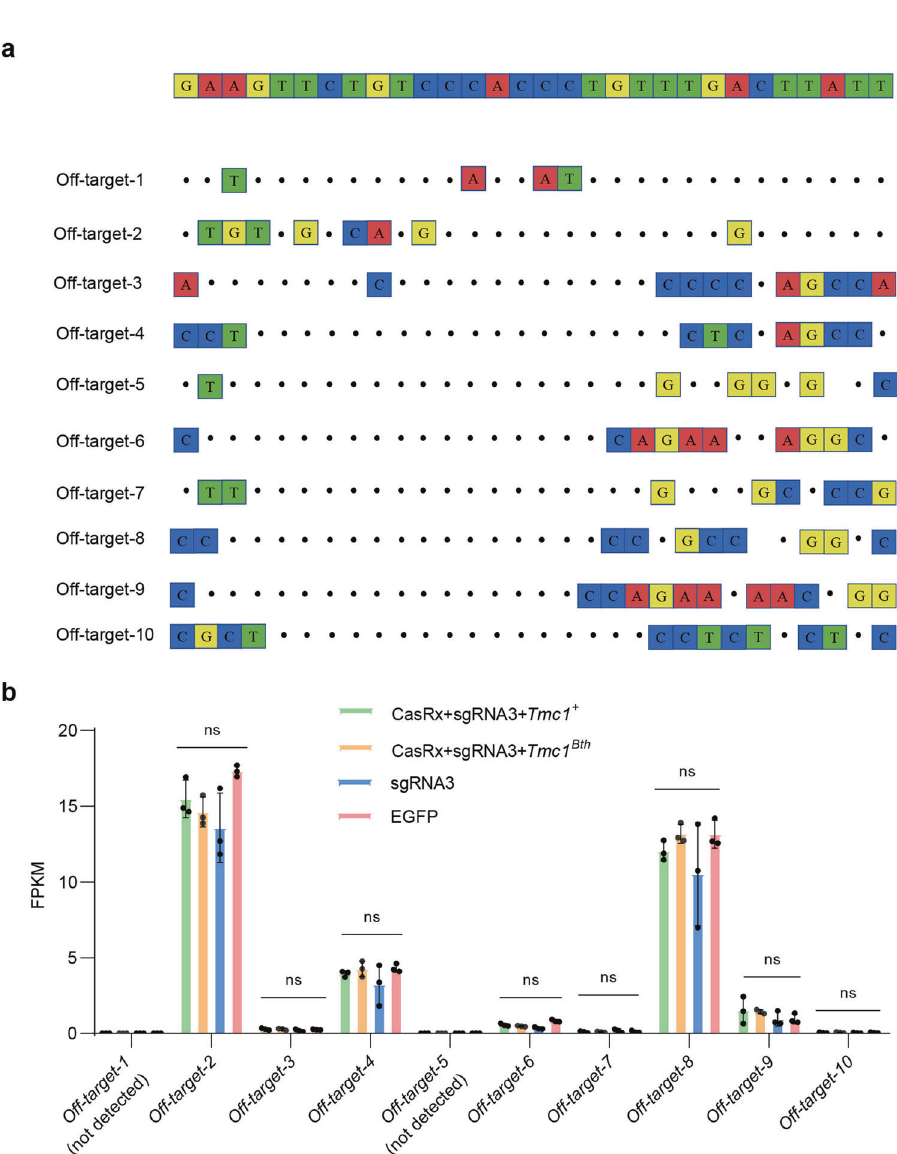
Fig. 2 Off-target analysis for RNA editing in 293T cells by RNA-Seq. a Off-target-1 to Off-target-10 are ten off-target sites detected by RNA-seq. Mismatches compared to the on-target site are shown and highlighted in color. The 30 bp sequence (On-target) targeted by the sgRNA3 is shown in the top row. b Off-target analysis for RNA editing in 293T cells by RNA-Seq. No signi fi cant difference was found in CasRx + sgRNA3 + mCherry- Tmc1 Bth , CasRx + sgRNA3 + mCherry- Tmc1 + or sgRNA3, when compared to EGFP. Data are shown as the mean ± SD. ns no signi fi cance. Statistical analysis was performed by multiple unpaired t-test Signal Transduction and Targeted Therapy (2022)